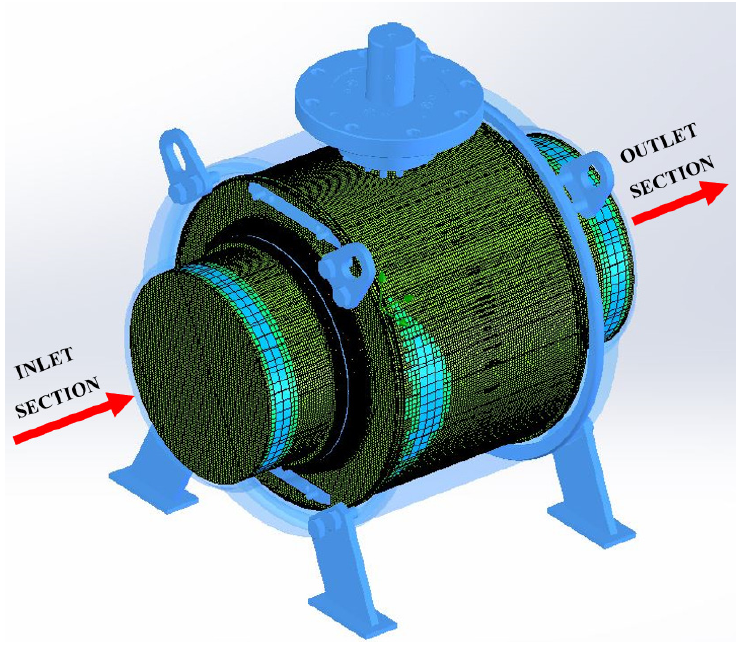
Figure 2. General view of the mesh (discretization network).